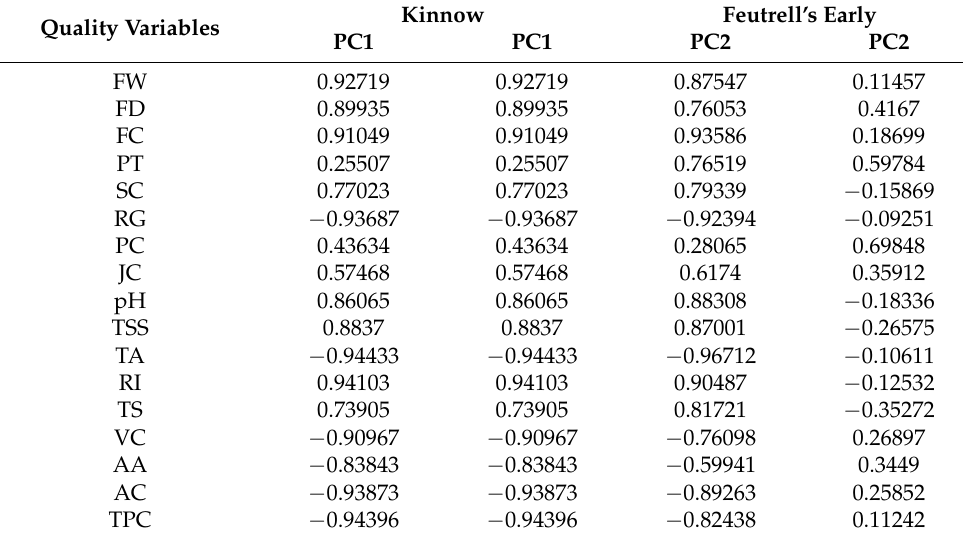
Table 3. The correlation between the quality variables and the first 2 principal components: PC1 represents mainly fresh weight, fruit circumference, fruit diameter, ripening index, and total soluble solids in both cultivars; PC2 explains peel thickness in Kinnow and peel content in Feutrell’s Early. Kinnow Feutrell’s Early Quality Variables PC1 PC1 PC2 PC2 FW 0.92719 0.92719 0.87547 0.11457 FD 0.89935 0.89935 0.76053 0.4167 FC 0.91049 0.91049 0.93586 0.18699 PT 0.25507 0.25507 0.76519 0.59784 SC 0.77023 0.77023 0.79339 − 0.15869 0.43634 0.43634